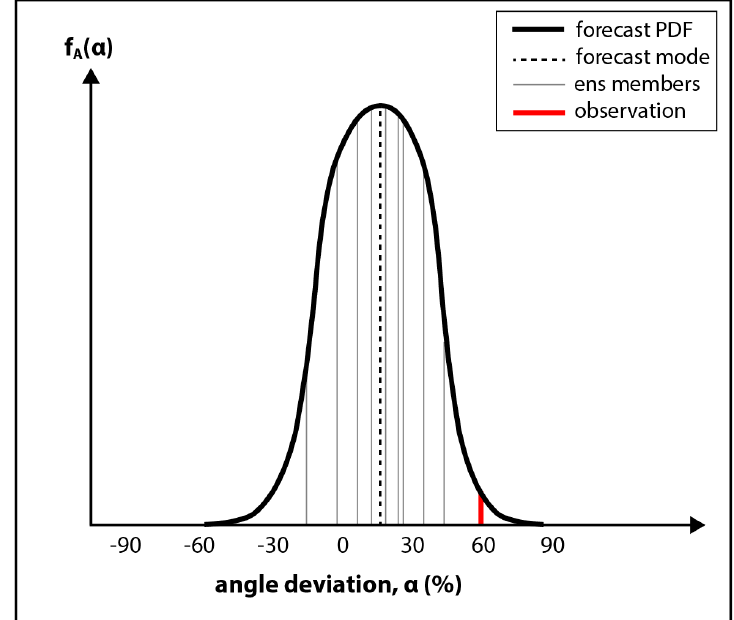
Figure 20. Schematic illustration of the impact that model errors have on the quality of a CAM ensemble with a small membership. The heavy solid black line represents the forecast probability density function (PDF) f A ( α ) of the supercell’s angle deviation from the mean wind, the dashed black line—the mode of the forecast PDF, the thin solid gray lines—10 randomly drawn ensemble forecast members and the heavy red line—the observed deviation of the supercell from the mean wind. Note that the idealized example presented in this diagram is based on results from the WRF.15may00utc experiment, as well as the hail reports from NIMH /